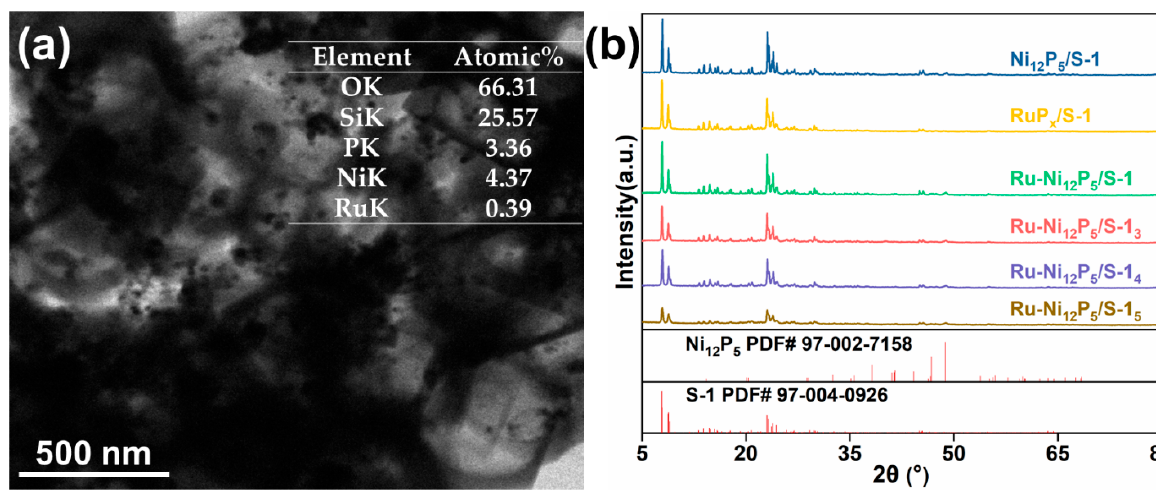
Figure 2. ( a ) TEM-EDS results of Ru-Ni 12 P 5 /S-1 5 and ( b ) XPD patterns of catalysts.